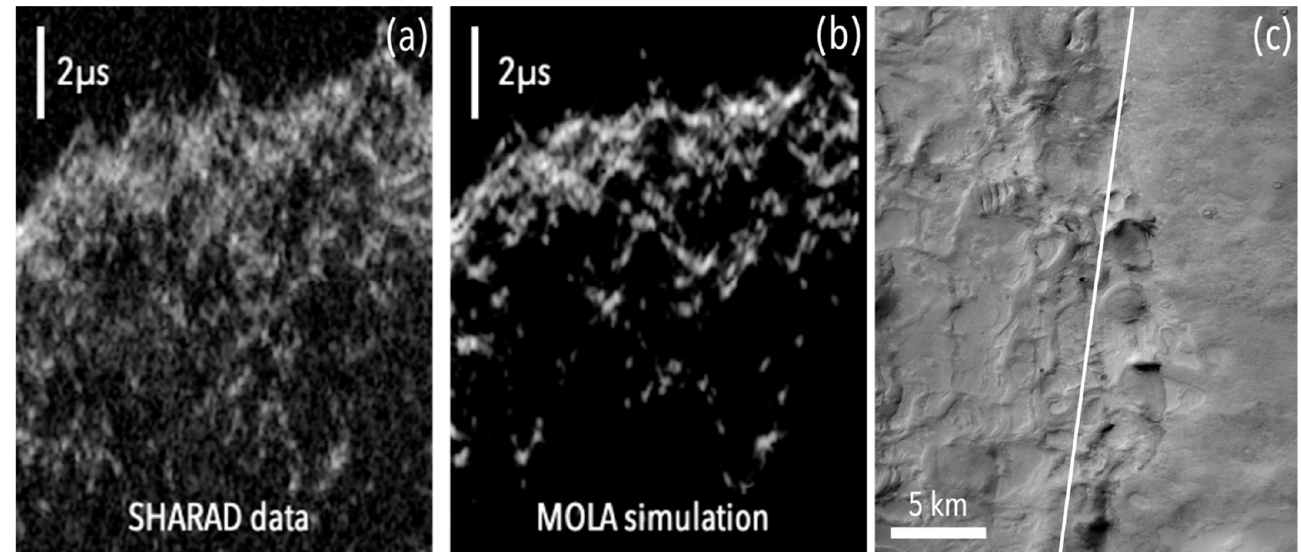
Figure 3. ( a ) A 40 km long portion of the SHARAD profile n°0806502 sounding Deuteronilus Men- sae; ( b ) corresponding simulation using a MOLA DTM; ( c ) HRSC image of the terrain at nadir in the area where the radargram was taken. The two reflectors circled in white are present in the SHARAD data, but not in the simulation, meaning that they probably originate from the subsurface. Note that the two top echoes (left and right of the radargram) are off-nadir echoes originating from plateaus, thus arriving before the stronger nadir echo.